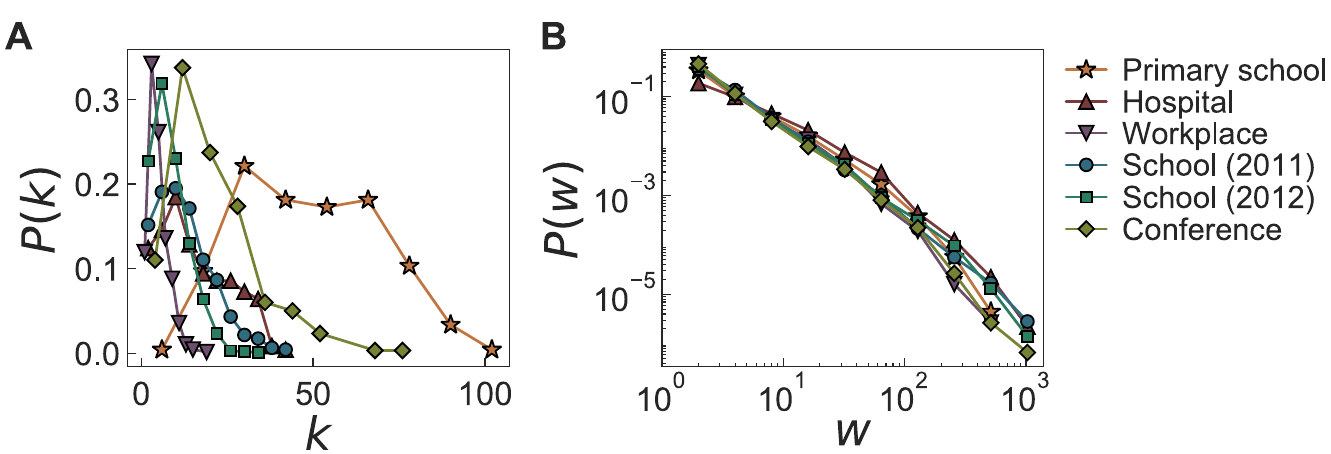
Fig 3. Degree distributions P ( k ) and weight distributions P ( w ) for empirical datasets. (A) P ( k ) and (B) P ( w ) of time-aggregated networks for six face-to-face interaction datasets, i.e., for the primary school ( ✰ ), hospital ( 4 ), workplace ( 5 ), school (2011) ( � ), school (2012) ( □ ), and conference ( ^ ). P ( k )s are linearly binned, while P ( w )s are logarithmically binned.